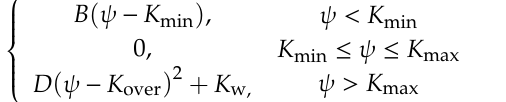
Table 1 sums up the parameters used in the numerical analyses of bone remodeling in the